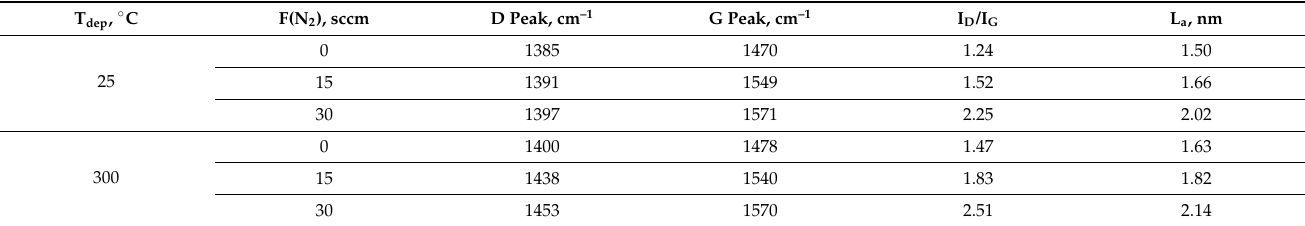
Table 5. Position of D and G band and ratio of their relative intensity for SiC x N y films versus the nitrogen flow ratio at RT and 300 ◦ C deposition